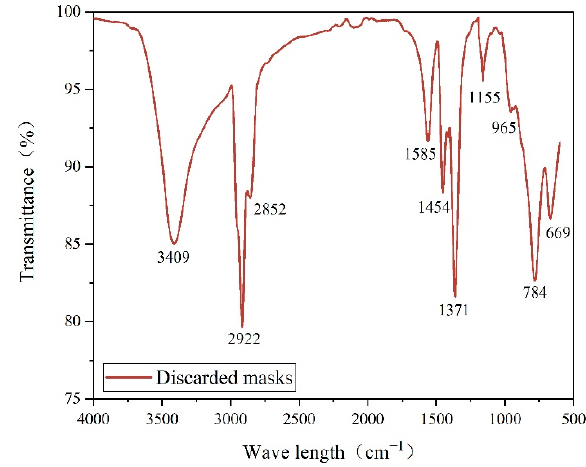
Figure 9. FTIR spectra of discarded medical masks.